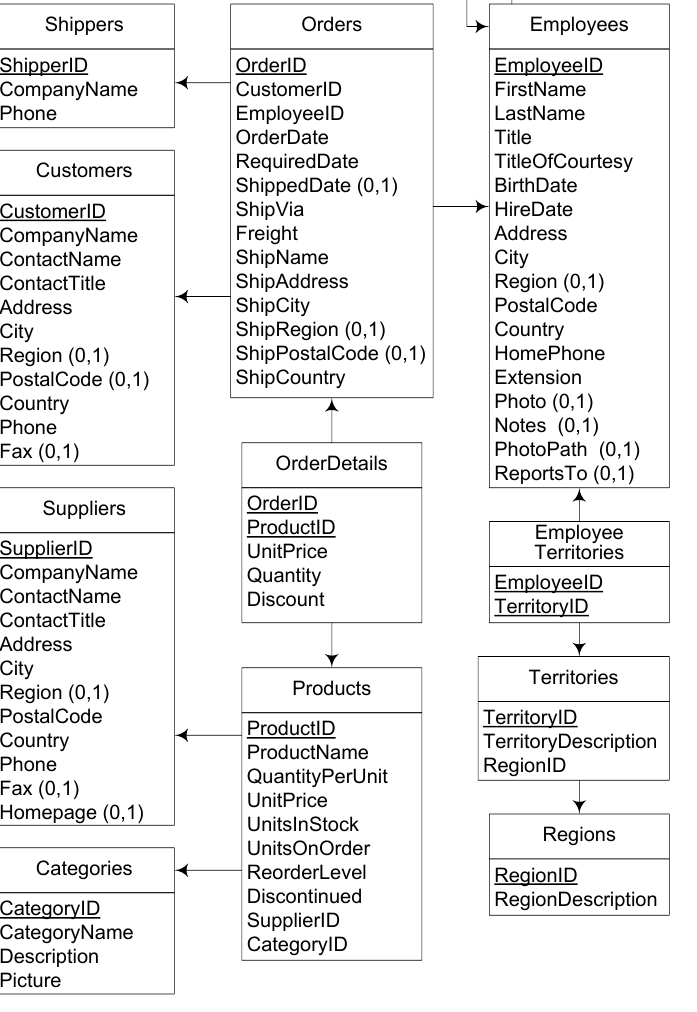
Figure 1: Schema of the Northwind database Figure 4. Northwind relational